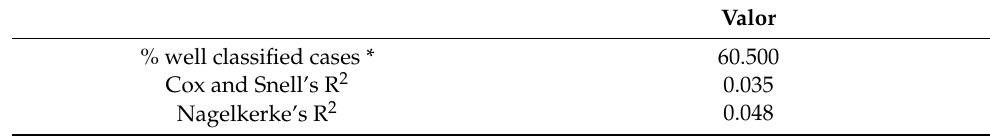
Table 8. Tests on the adequacy of the model. Shows Diabetes